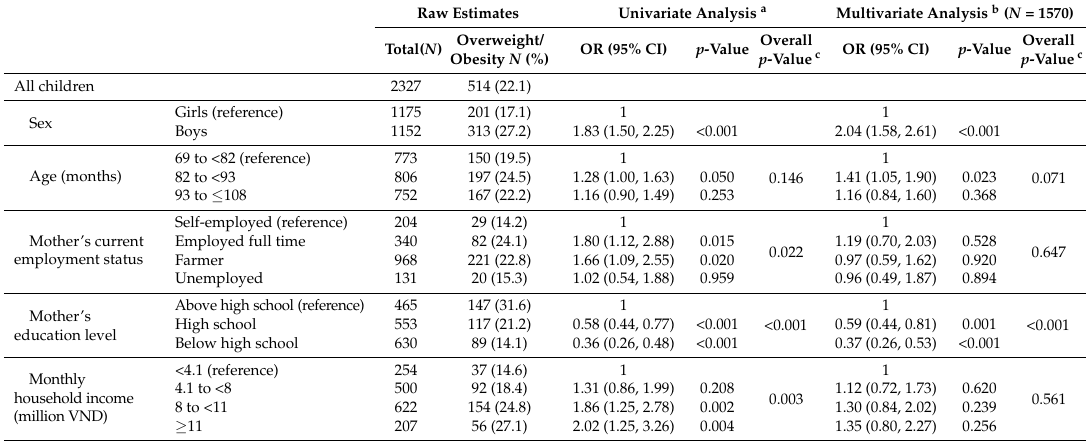
Table 6. Prevalence of overweight/obesity (BMI-for-age z -score > 1) and associated sociodemographic factors in 6–9-year-old children in rural areas of